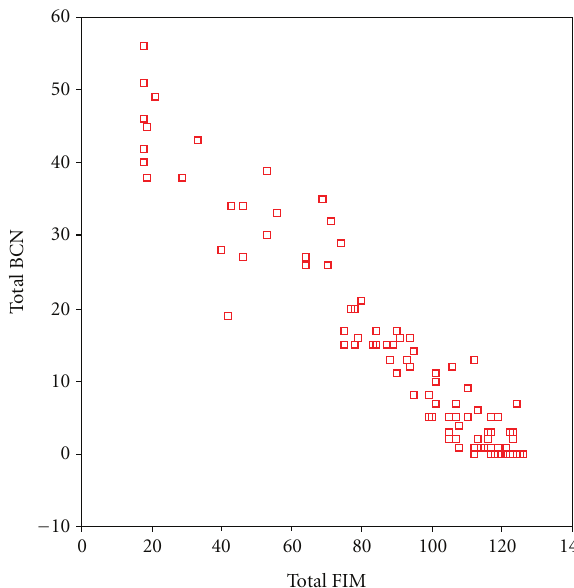
Figure 1: Scatterplot showing the distribution of the NPDS total BCN score and the FIM total score.